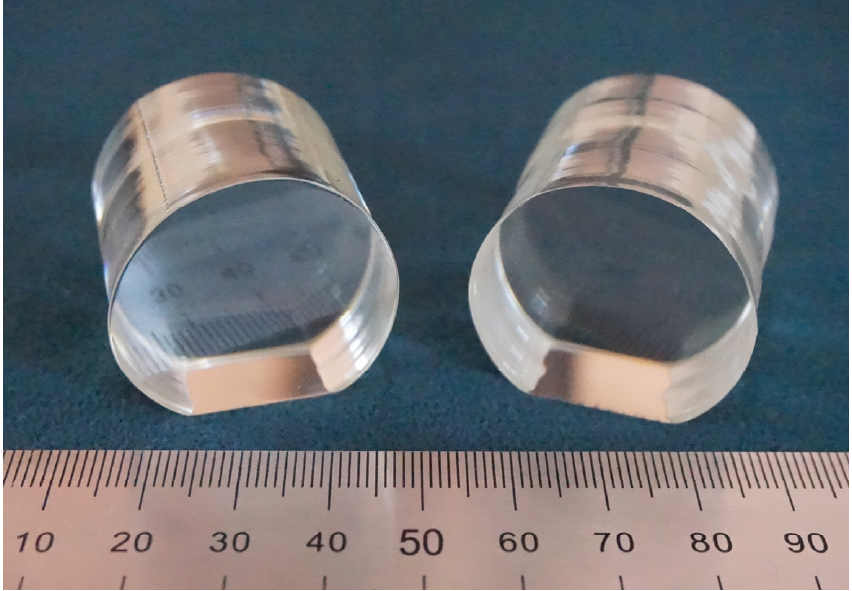
Figure 2. LiNbO 3 :B ((B) = 0.0034 and 0.0079 wt% in the charge) crystals; samples are turned to single